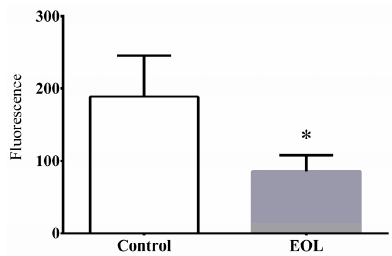
Figure 5. The effect of EOL on reducing ROS in C. elegans . Differences were considered to be significant at p < 0.05 (*).